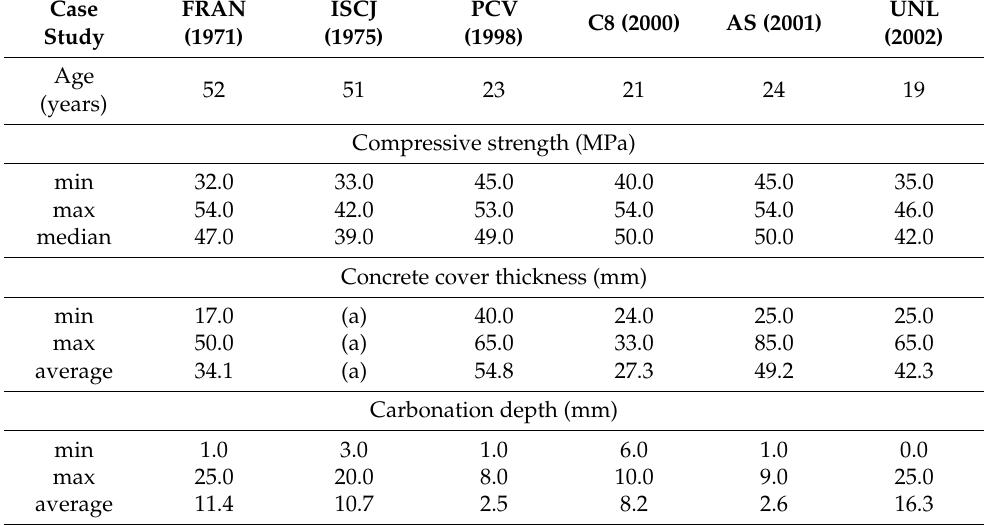
Table 11. Summary of the main characteristics of the architectural concrete in sampling